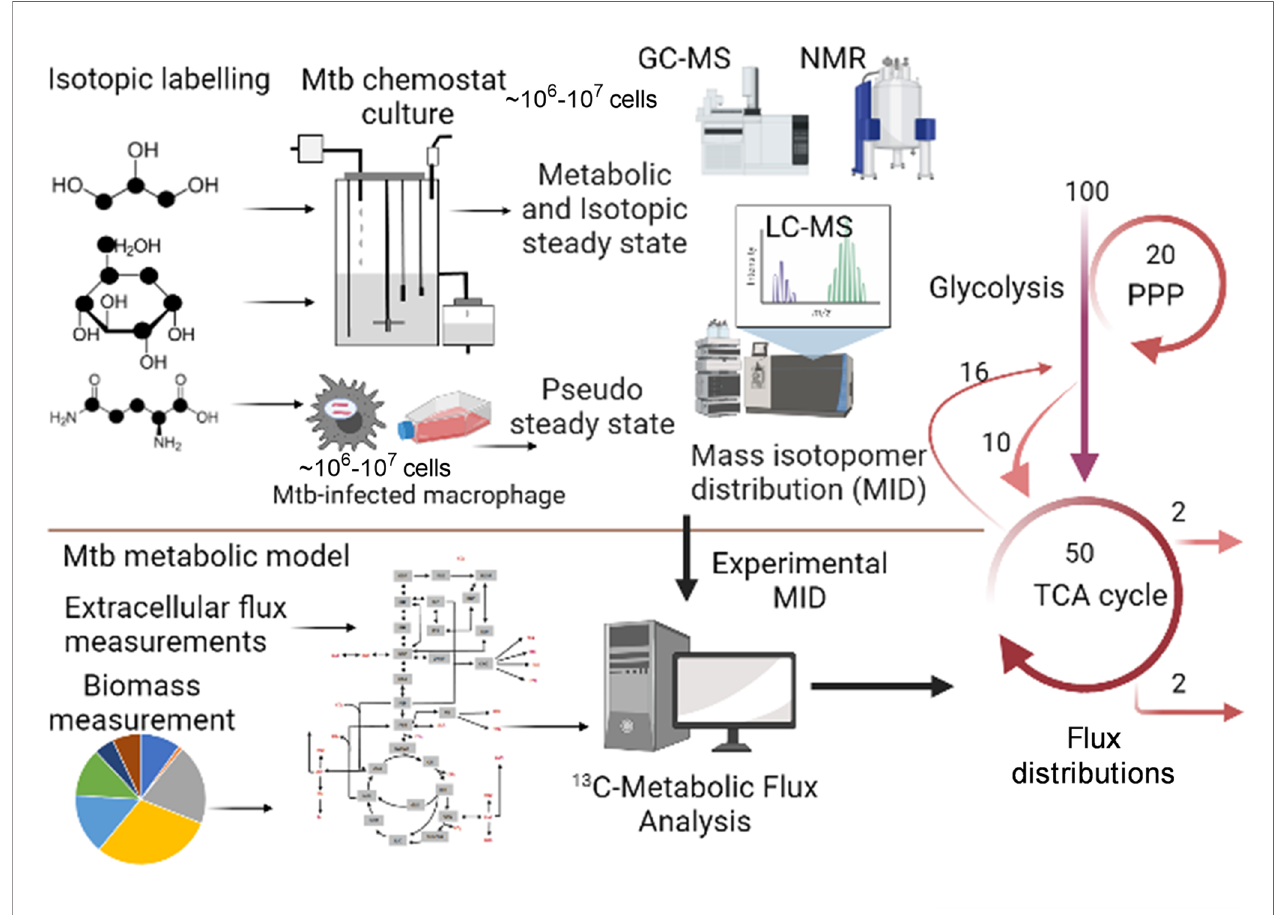
FIGURE 2 | General work fl ow of steady state 13 C-Metabolic Flux Analysis (MFA). The application is shown for measuring metabolic fl uxes of Mtb in vitro in chemostat and during intracellular growth in macrophages. The methodology includes growth of the biological system in isotopically labelled media, followed by achievement of metabolic and isotopic steady state for chemostat set up or assuming pseudo steady state from macromolecular measurements at various time points of isotopic labelling. Metabolomics and mass isotopomer distributions (MIDs) are measured using GC-MS, LC-MS or NMR. A minimum of 10 6 -10 7 cells is required for robust MID measurements. The computational part of 13 C-MFA includes construction of a metabolic model consisting of atomic transitions for central metabolic reactions. The model is constrained with extracellular fl ux and biomass measurements. Measured MIDs are incorporated into the model and the model is cimulated with MFA computational platform to derive best- fi t metabolic fl uxes that de fi nes the metabolic phenotype of the system under study. Created with